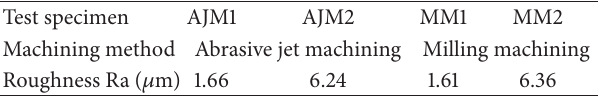
Table 3: Machining methods and surface roughness of test speci-